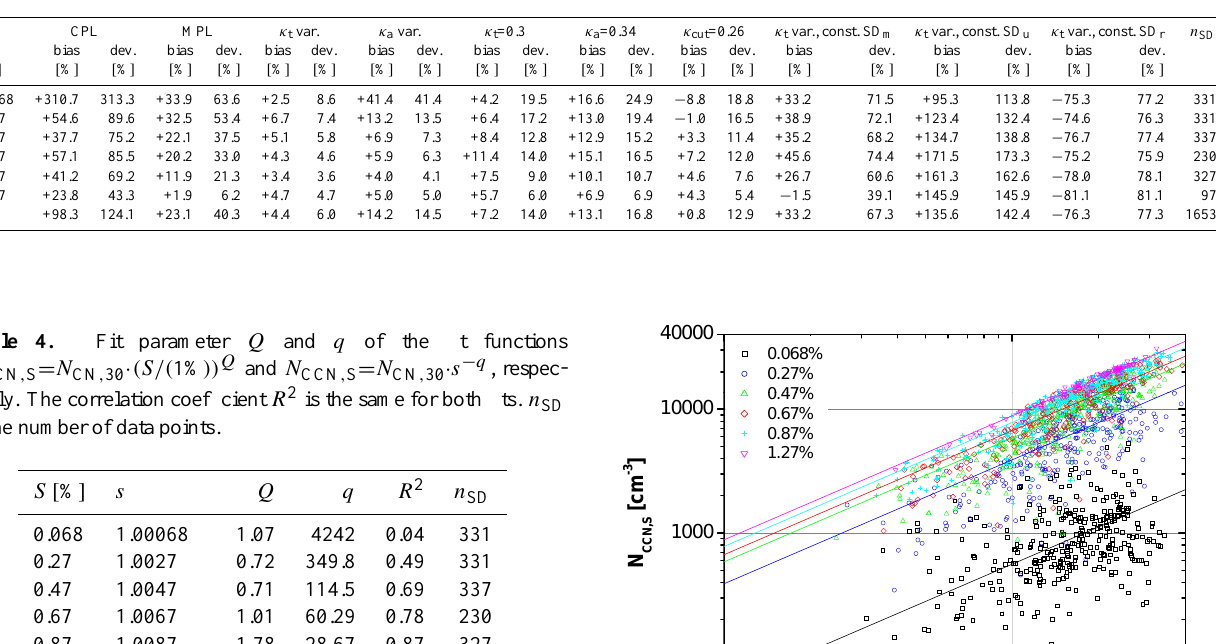
Table 3. Characteristic deviations between observed CCN number concentrations N CCN , S and CCN number concentrations predicted by different model approaches ( N CCN , S , p ): arithmetic mean values of the relative bias ( 1 b N CCN , S =( N CCN , S , p − N CCN , S )/ N CCN , S ) and of the